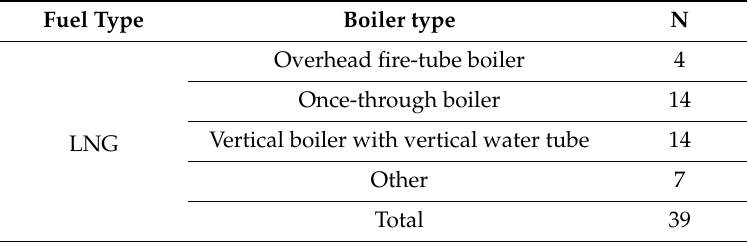
Table 2. Sampling status of objective facilities.